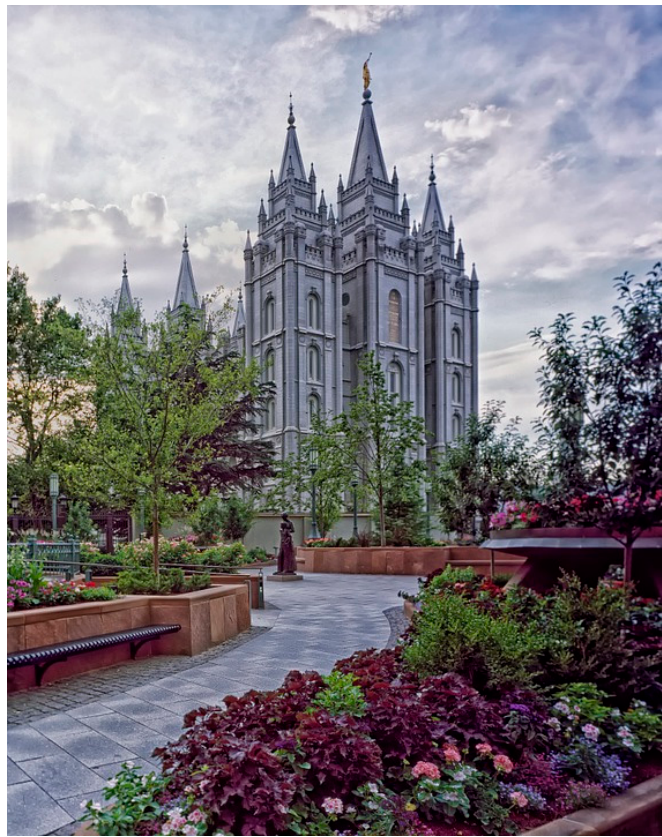
Figure 1. A photograph of the Salt Lake Temple. Source: https://pixabay.com/photos/salt-lake-city-utah-temple-398843/. Used with permission.